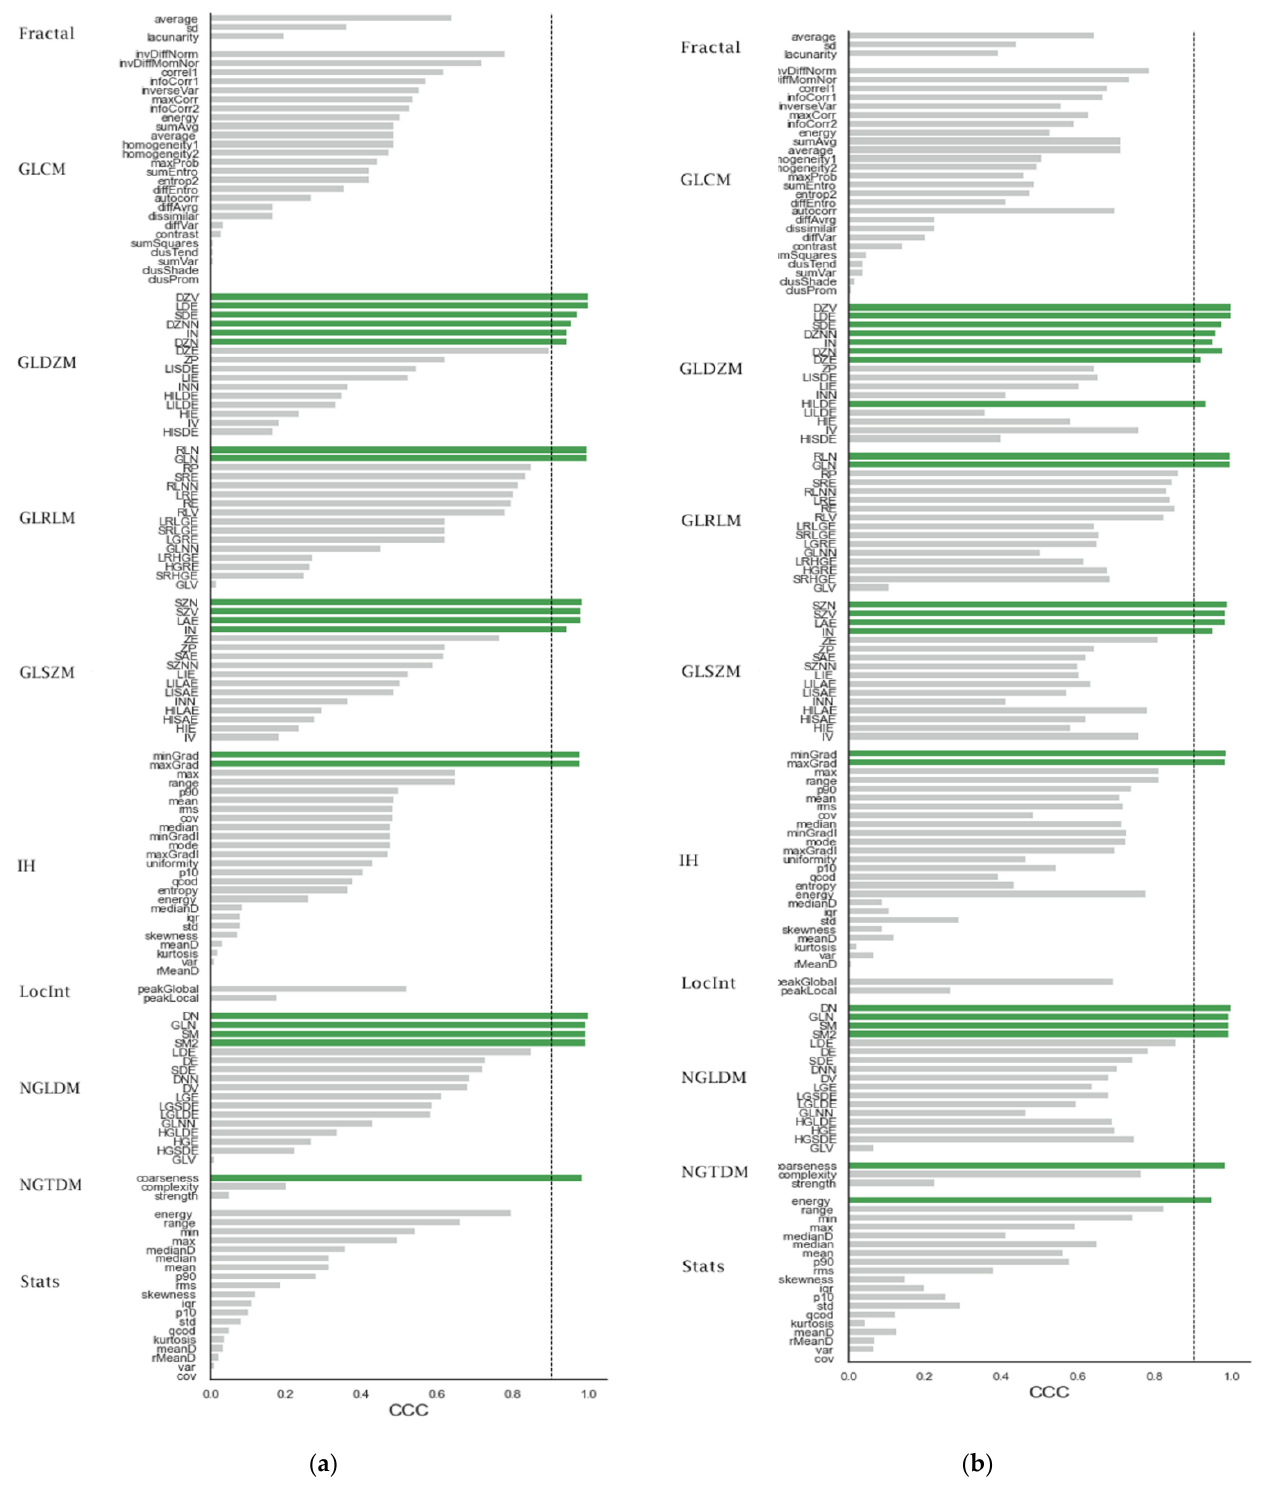
Figure 3. ( a ) The CCC values for the different HRFs before ComBat harmonization. ( b ) The CCC values for the different HRFs after ComBat harmonization. HRFs after ComBat